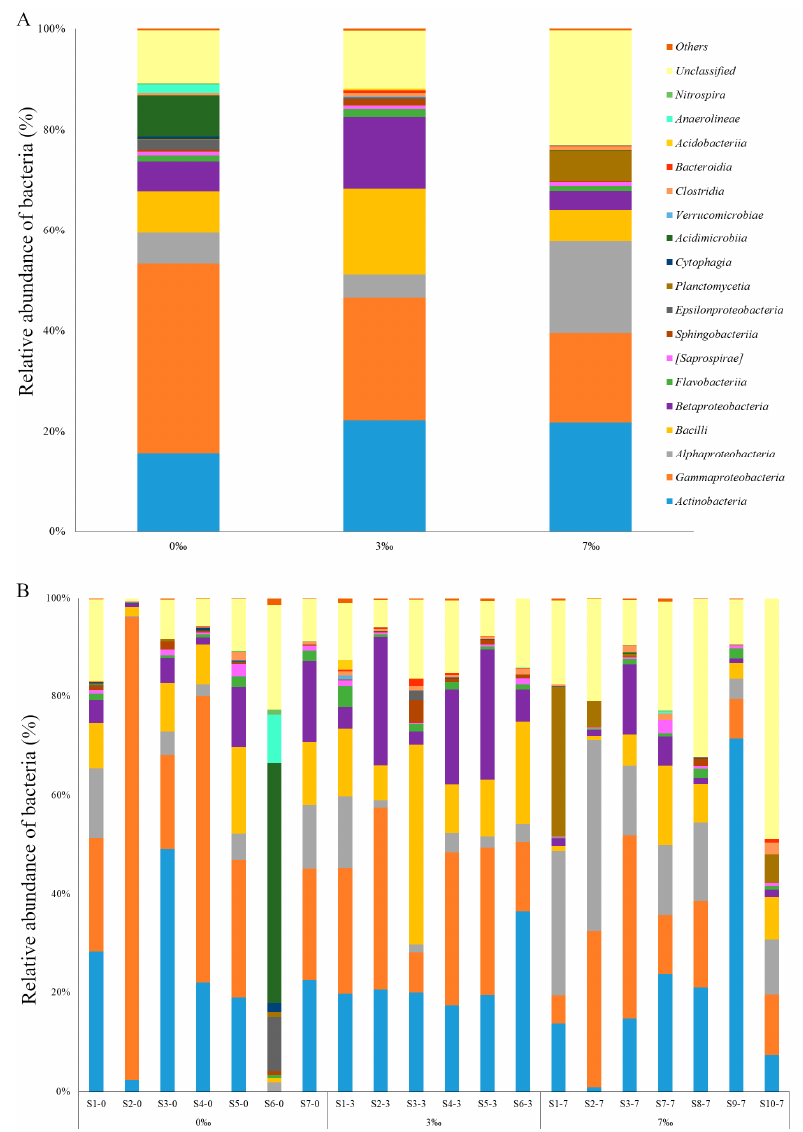
Figure 4. Relative abundance (%) of the most prevalent bacterial classes in three groups kept at different levels of salinity ( A ) and in individual pike ( B ). Figures show all classes with an abundance > 0.5%. Classes with an abundance ≤ 0.5% are pooled and labeled as “Others”.